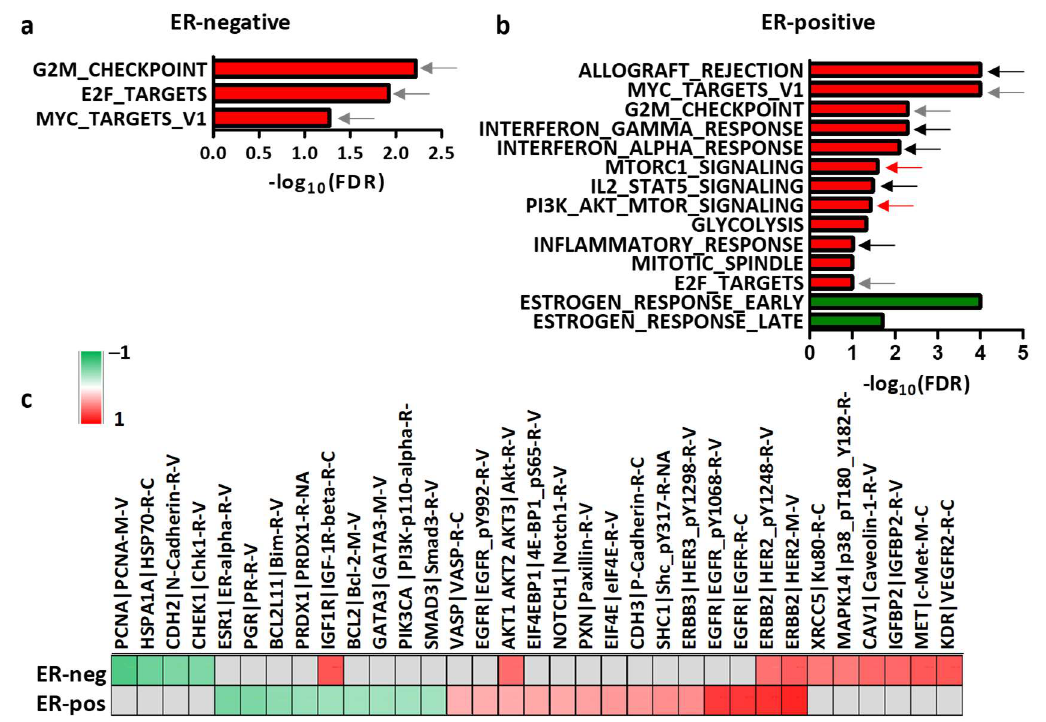
Figure 3. Correlation between HER2 mRNA and tumor molecular characteristics according to ER expression. ( a , b ) Bar plot showing HALLMARK pathways significantly (FDR < 10%) and positively (red bars) or negatively (green bars) correlated with HER2 mRNA in ER-negative ( a ) and ER-positive ( b ) HER2+ BCs of the GHEA cohort as evaluated by GSEA. FDR: false discovery rate. Gray arrows: proliferation-related pathways; red arrows: oncogene downstream signaling pathways; black arrows: immune-related pathways. ( c ) Proteins significantly ( p < 0.05) correlated with HER2 mRNA levels in the TCGA dataset. Pearson’s r is color-co3.4. Association between HER2 Expression and HER2-Addiction in BC Cell Lines